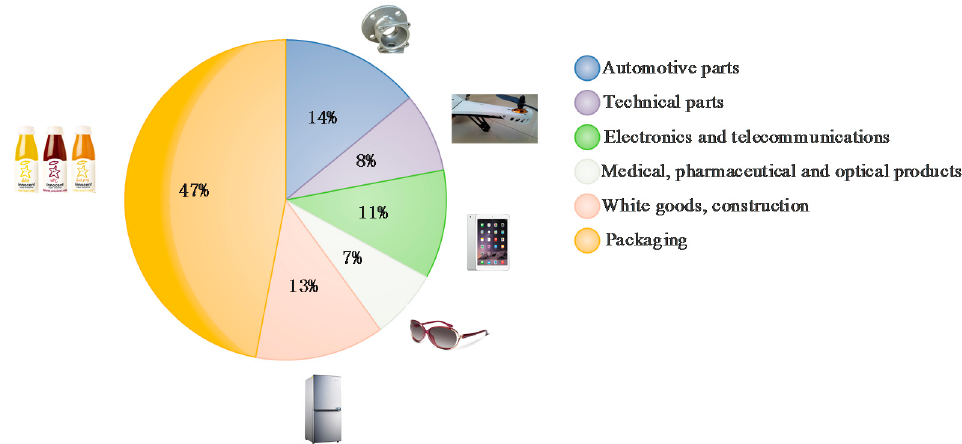
Figure 1. The application situation in the end product market of injection-molding machines (IMMs).